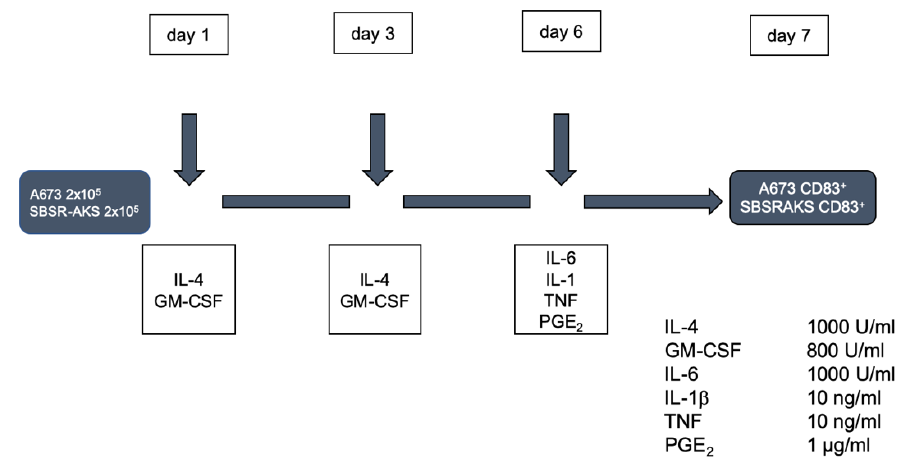
Figure 1. Protocol for culturing EwS cell lines A673 and SBSR-AKS in vitro using IL-4, GM-CSF, IL-6, IL-1β, TNF, and PGE.